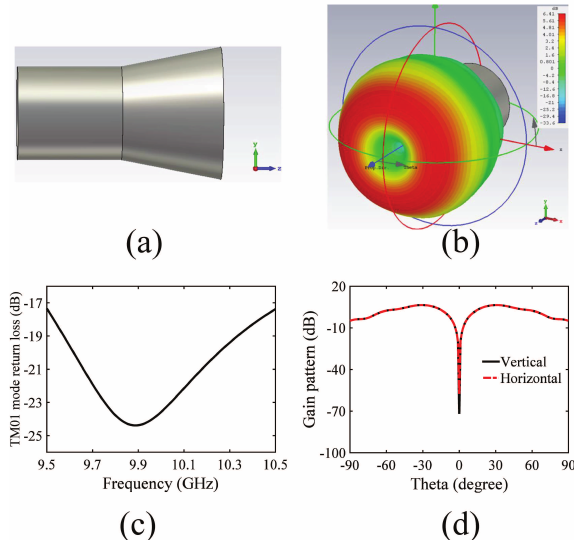
Figure 5: Characteristics of the designed conical horn an- tenna as a feed of the reflectarray aperture. (a) Schematic model. (b) Simulated three-dimensional doughnut-shaped pattern. (c) Simulated return loss for the TM 01 mode. (d) Simulated radiation patterns for vertical and horizontal po- larizations at 10 GHz.